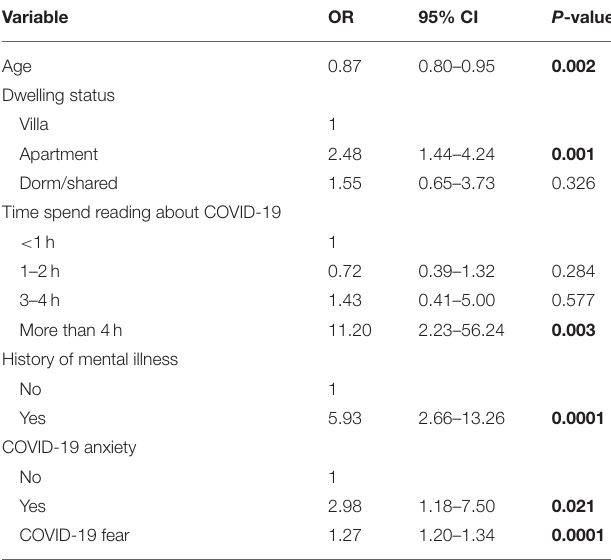
TABLE 6 | Predictors of the psychological distress among study participants.